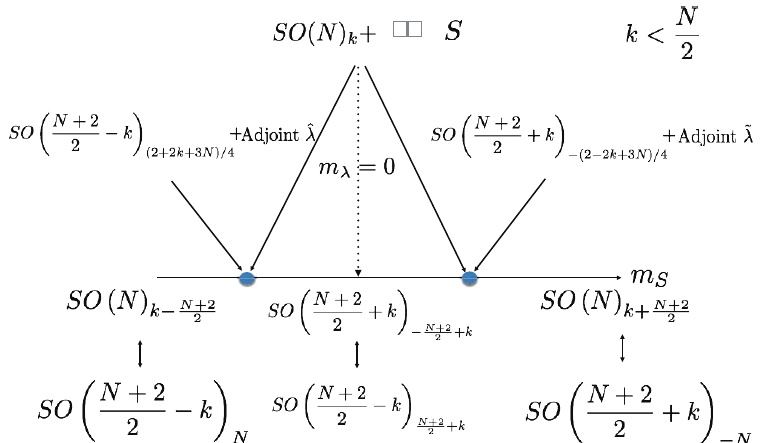
Figure 17: The phase diagram of SO ( N ) gauge theory with a fermion in a symmetric- k traceless tensor for k < N / 2. There are two phase transitions between different infrared TQFTs. We propose a dual fermionic description of the two